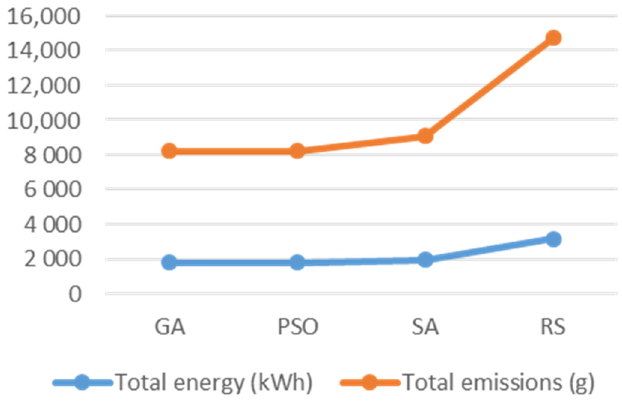
Figure 10. Total energy and emissions of the case of thirty bins. Table 6. Estimated accrued emissions in g of the case of thirty bins.